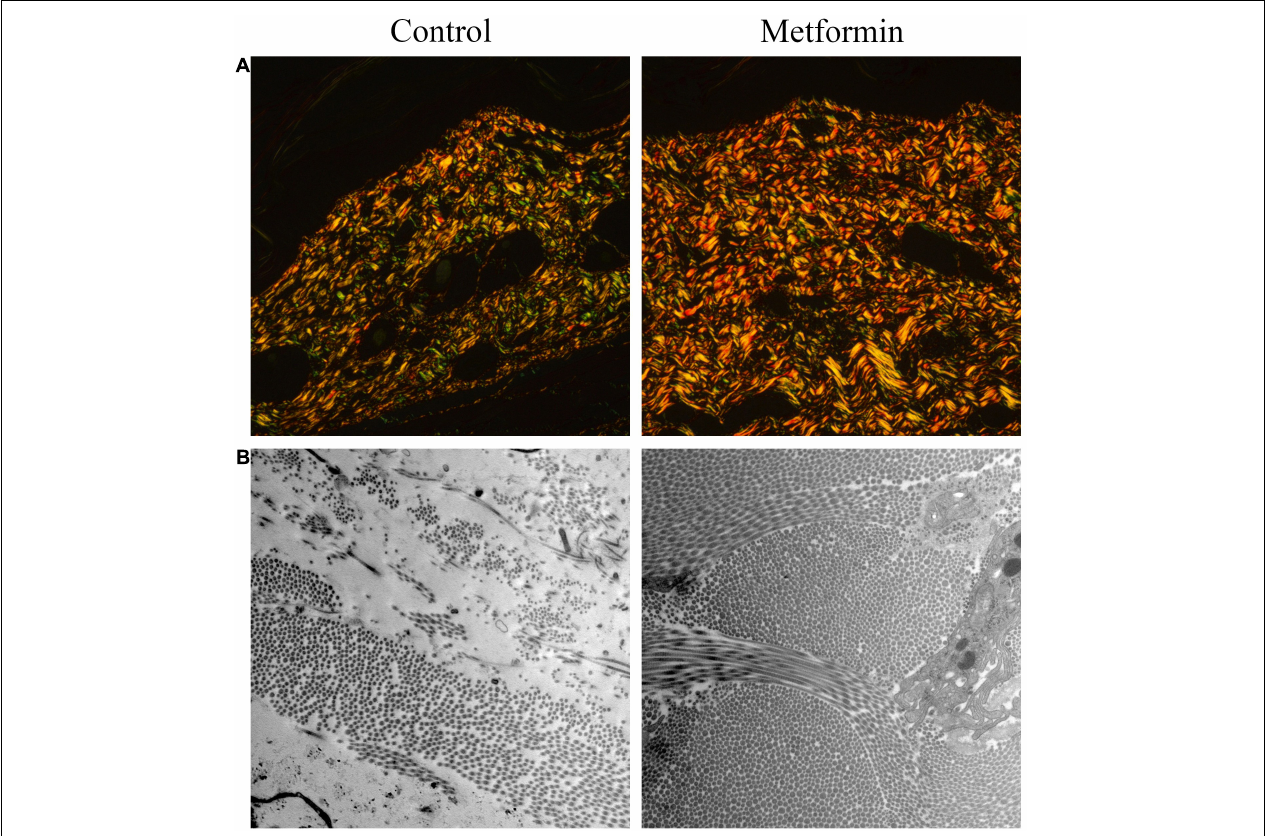
FIGURE 4 | Picrosirius Red staining ultrastructural analysis of dermal collagen fibrils. (A) Picrosirius Red images showed increased neocollagen development (yellow to orange) in the metformin-treated group. (B) TEM images revealed an improved arrangement of collagen fibrils in the metformin-treated group without a distorted ultrastructure, whereas collagen fibrils in the control group were broken and disorganized. Magnification: 15,000 ×